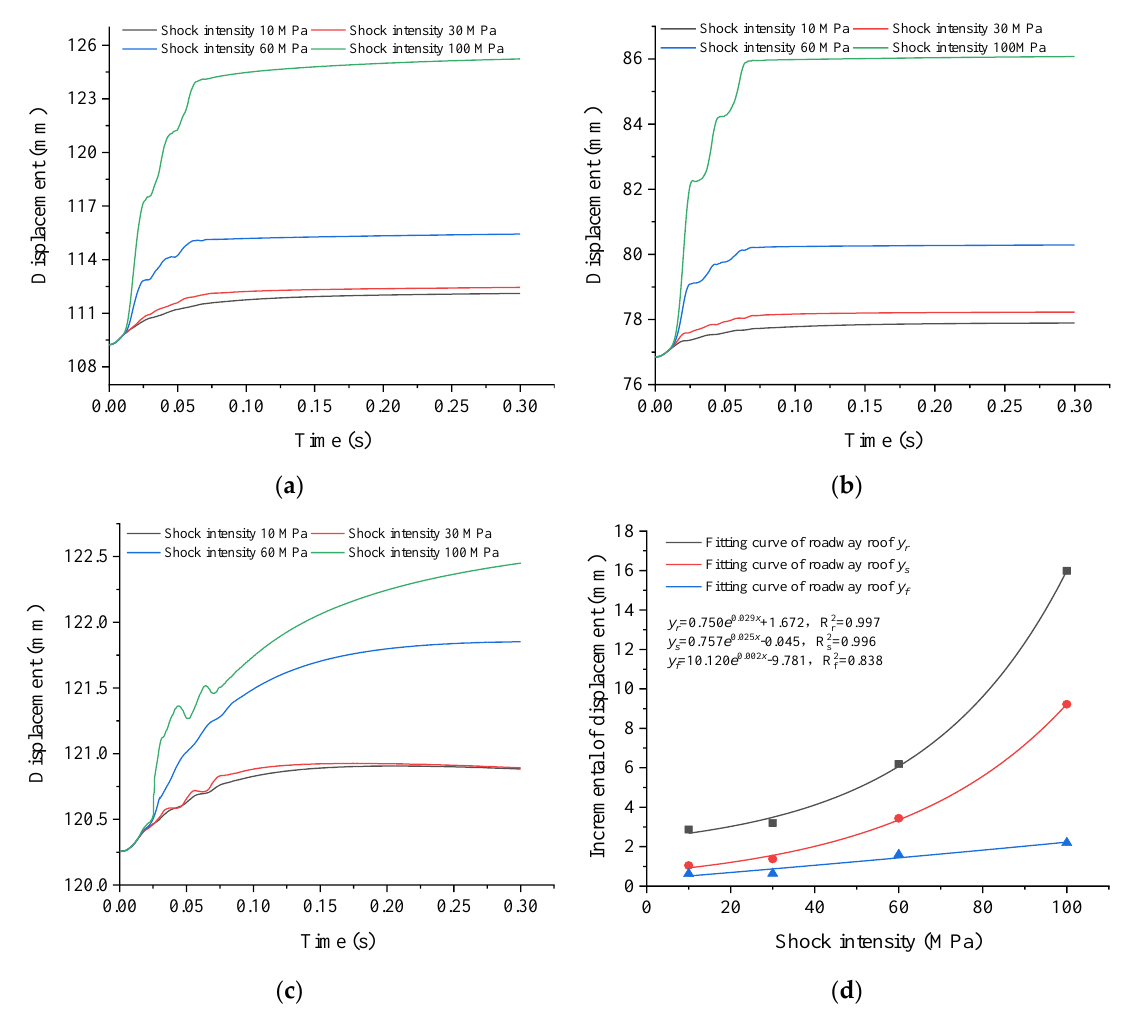
Figure 8. Displacement–time curve of the surrounding rock of the roadway for different shock intensities. ( a ) Roadway roof; ( b ) roadway side; ( c ) roadway floor; ( d ) displacement increment fitting curve.